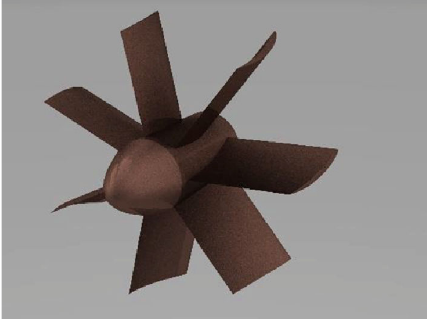
Figure 7: Stator image produced with a NACA 5505 cross section.